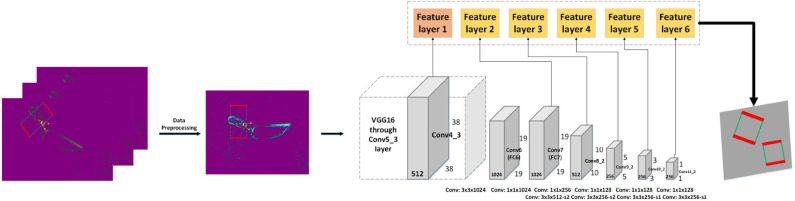
The structure of our grasping detection system. The event streams are processed by three encoding methods and merged into a three-channel event frame, which is then fed into the grasping algorithm. The backbone network extracts the features, and six feature maps are employed for grasp pose estimation. Gray blocks indicate network layers and color blocks represent feature layers.